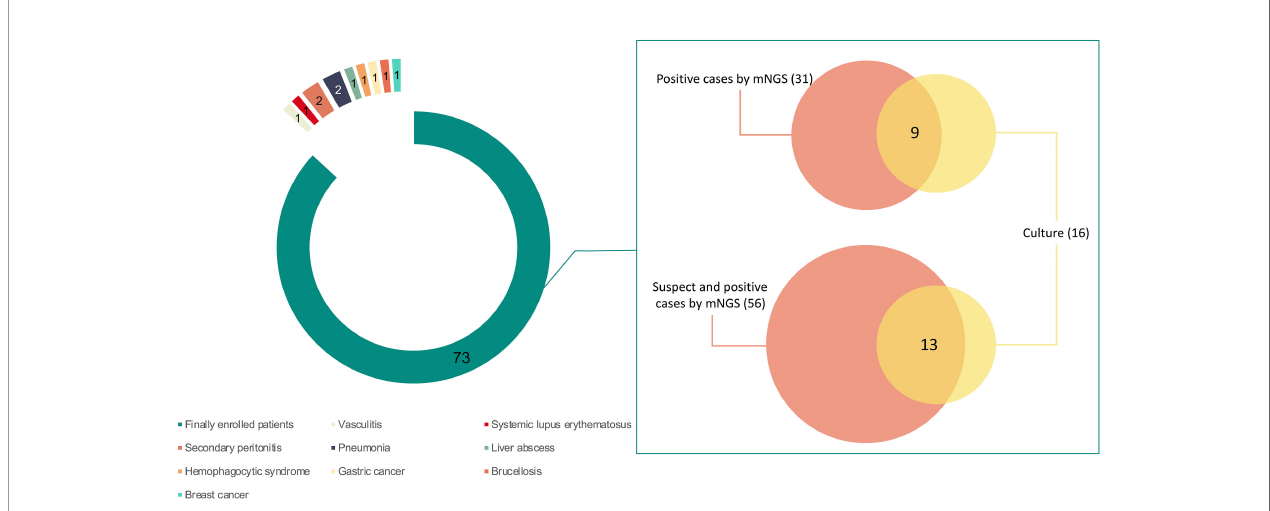
FIGURE 1 | The enrolled patients and their detected results by metagenomic next-generation sequencing (mNGS) and culture. Seventy-three out of 84 patients were fi nally enrolled in this study. Sixteen patients were positive by culture. A total of 56 patients were detected with pathogens by mNGS, of whom 31 were considered as positive. Pathogens were found in 13 patients by both mNGS and culture, and 9 were considered as positive by both methods. Of the 9 patients with positive results, 7 were detected with bacteria consistent at the genus level and 5 were with bacteria consistent at the species